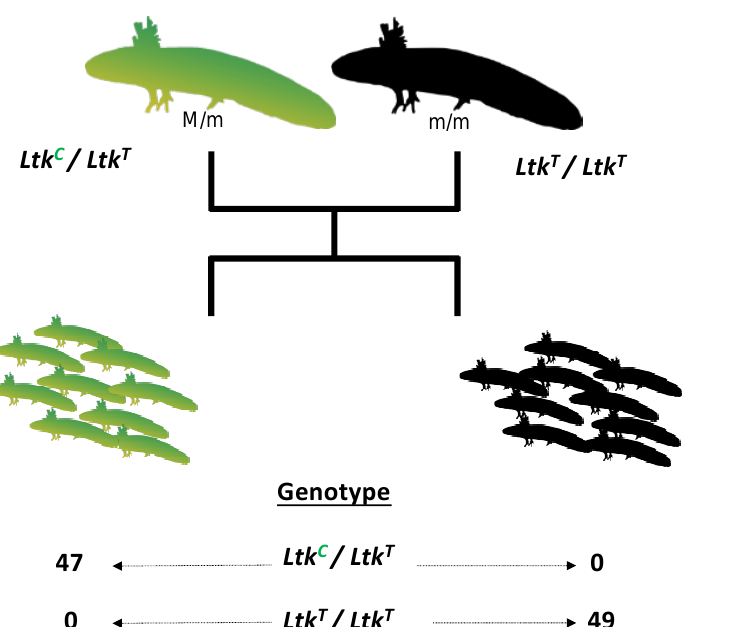
Figure 4. Genetic linkage analysis of melanoid and Ltk . An SNP within an Ltk exon was identified